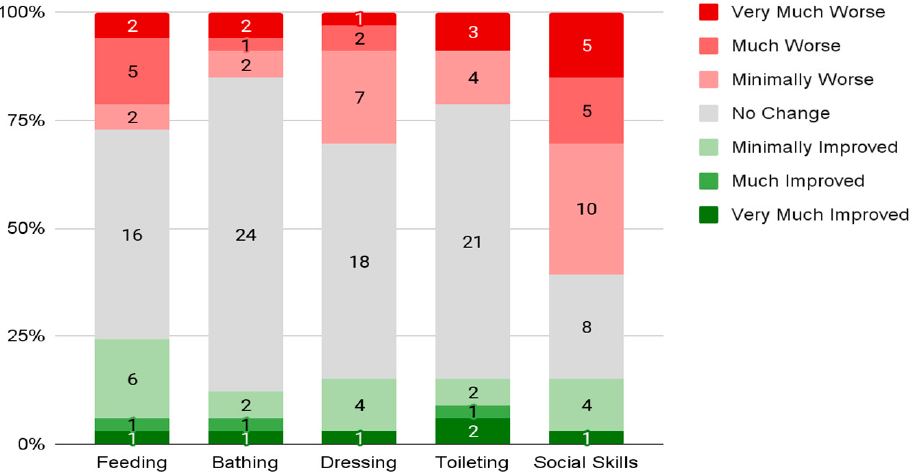
Figure 3. Reported change in daily living skills.